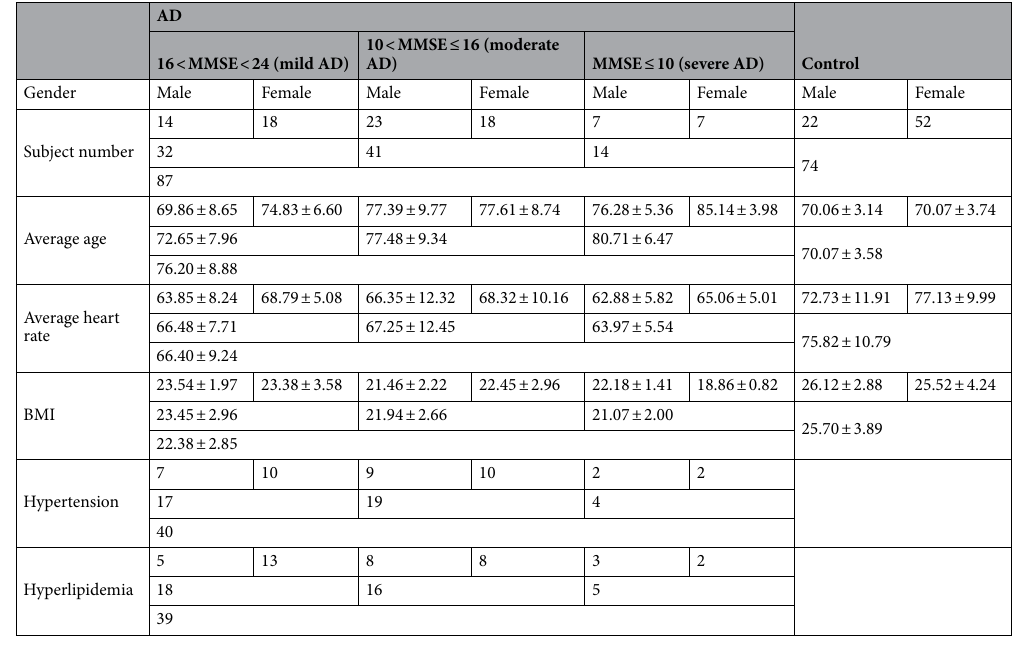
Table 1. Characteristics of